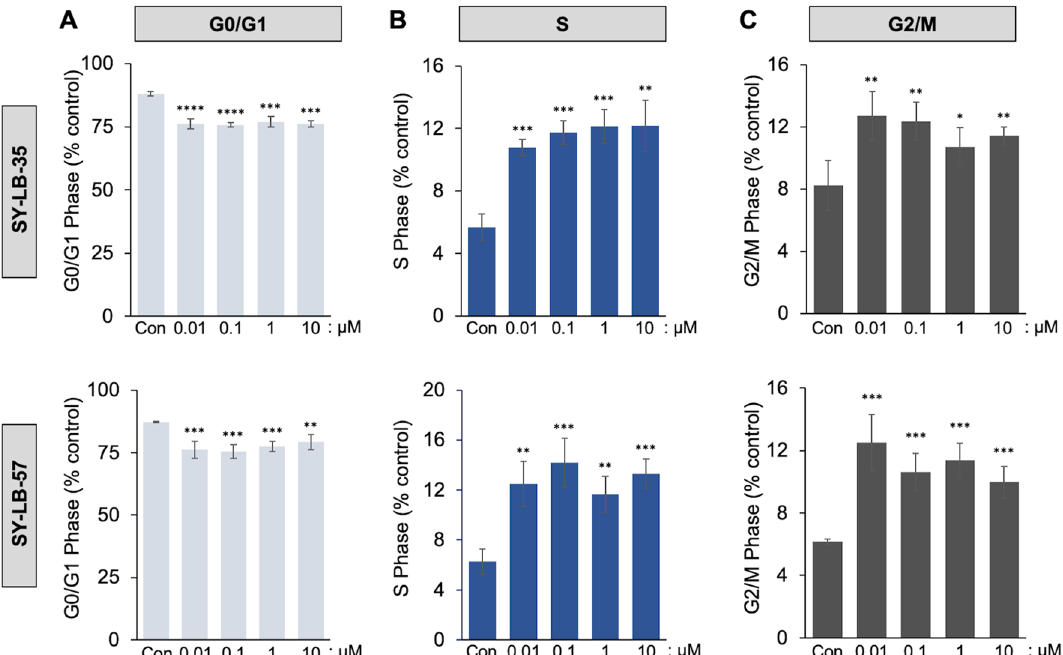
Figure 9. Shifts to S and G2/M phases of the cell cycle induced by SY-LB-35 and SY-LB-57. Serum-starved C2C12 cells were treated with SY-LB-35 (top row) and SY-LB-57 (bottom row) for 24 h. An equal number of cells (~ 10 6 cells per treatment) was collected for flow cytometry analysis. Quantitative analysis of the distribution or proportion of cells in each phase was carried out with at least 20,000 cells per sample. Cell cycle analysis demonstrated that SY-LB-35 and SY-LB-57 (0.01–10 µM) caused significant shifts in the phases of the cell cycle from G0/G1 phases (A ) to S ( B ) and G2/M ( C ) phases compared with control, untreated C2C12 cells. SY-LB-35: Con (G0/G1: 88%, S: 6%, G2/M: 8%); 0.01 µM (G0/G1: 76%, S: 11%, G2/M: 13%); 0.1 µM (G0/G1: 76%, S: 12%, G2/M: 12%); 1 µM (G0/G1: 77%, S: 12%, G2/M: 11%); 10 µM (G0/G1: 76%, S: 12%, G2/M: 11%); SY-LB-57: Con (G0/G1: 87%, S: 6%, G2/M: 6%); 0.01 µM (G0/G1: 76%, S: 13%, G2/M: 13%); 0.1 µM (G0/ G1: 76%, S: 14%, G2/M: 11%); 1 µM (G0/G1: 77%, S: 12%, G2/M: 11%); 10 µM (G0/G1: 79%, S: 13%, G2/M: 10%). Each bar represents mean ± SEM (n = 3) with each experiment carried out in triplicate (**** p < 0.0005; *** p < 0.001; ** p < 0.01; * p <